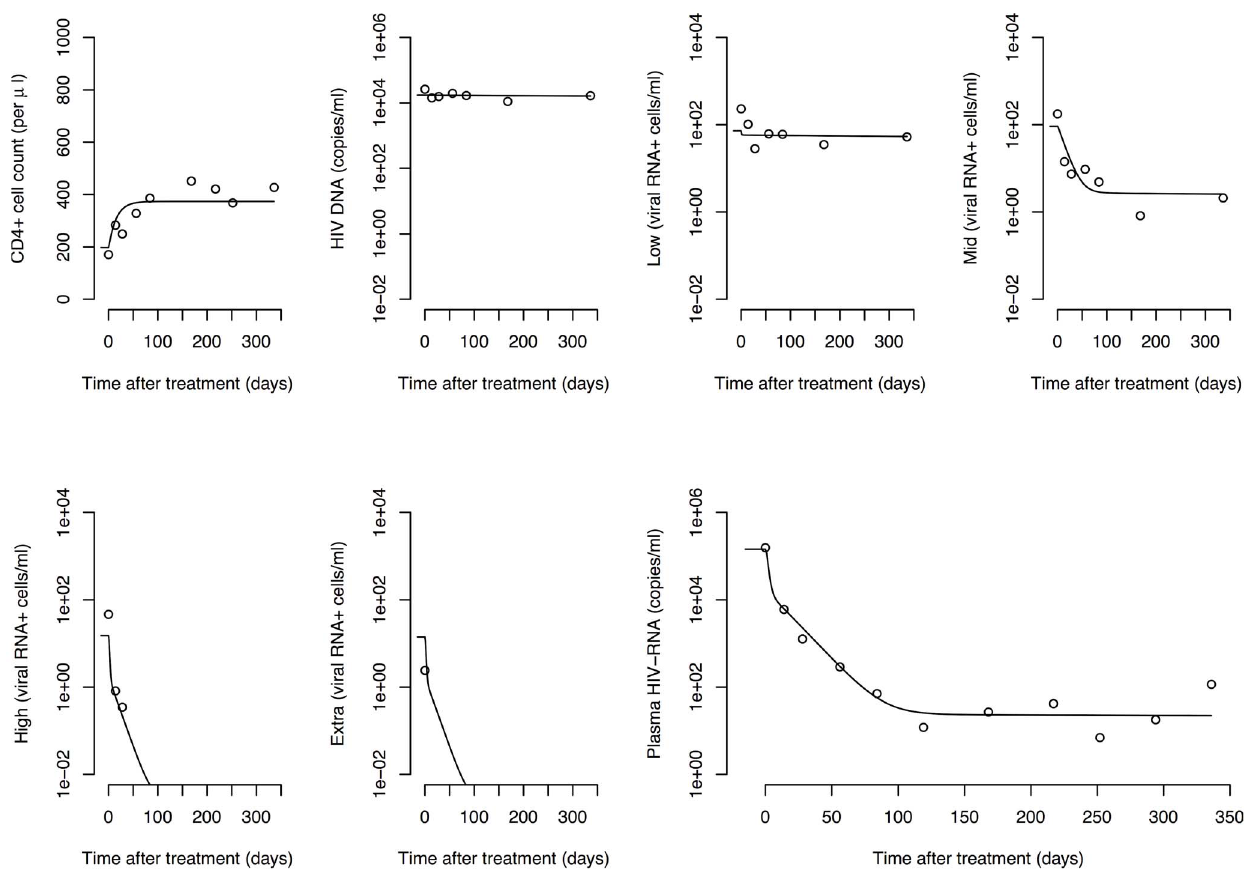
Figure 4. HIV-1 dynamics during cART. Circles denote measured data of patient 112 and lines represent the best fit of the default model. Model fits to data of the four other patients are given in Text S1 .